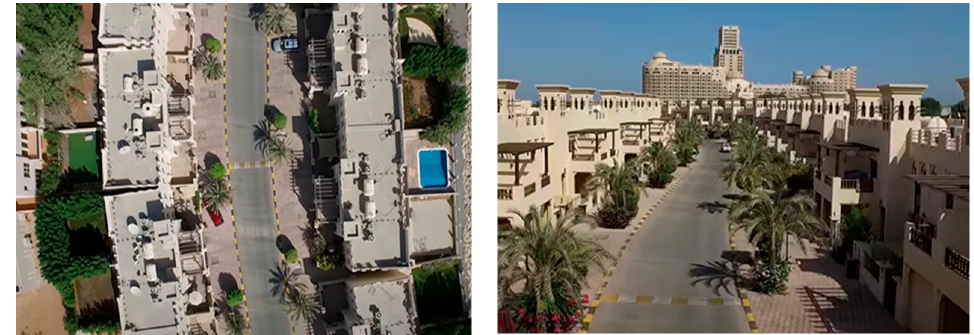
Figure 4. Top view and street view of the Townhouses in Al Hamra village, RAK, UAE.